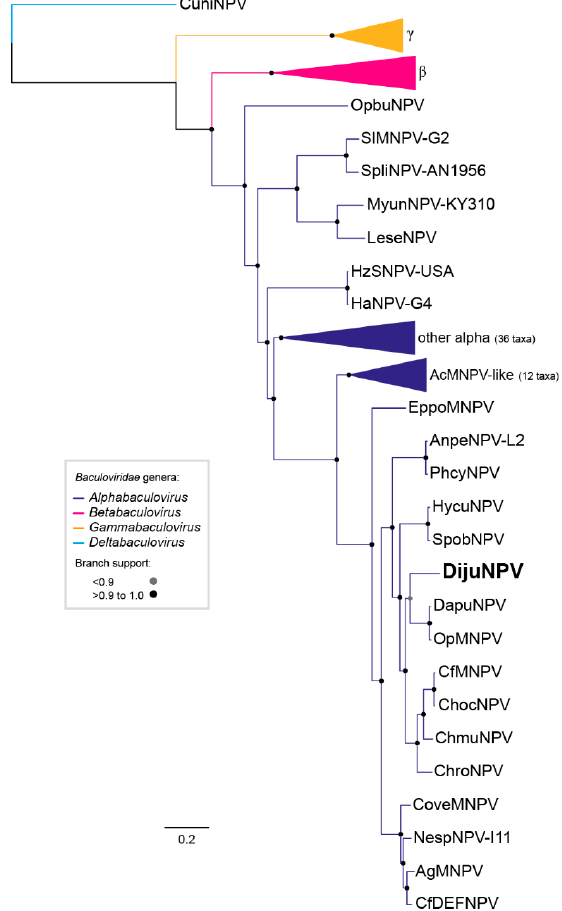
Figure 2. DijuNPV is an alphabaculovirus. Maximum likelihood inference based on the concatenated amino acid sequences of 38 core genes of all complete baculovirus genomes (Table S1). The branch support was determined by the Shimodaira ‐ Hasegawa ‐ like method. Some branches were collapsed for clarity: members inside genus Gammabaculovirus (orange), members inside genus Betabaculovirus (pink), and members inside genus Alphabaculovirus (dark blue). The deltabaculovirus CuniNPV was used as the root (light blue). We collapsed gammabaculovirus, betabaculovirus, some alphabaculovirus, and the Autographa californica multiple nucleopolyhedrovirus (AcMNPV) ‐ like viruses.